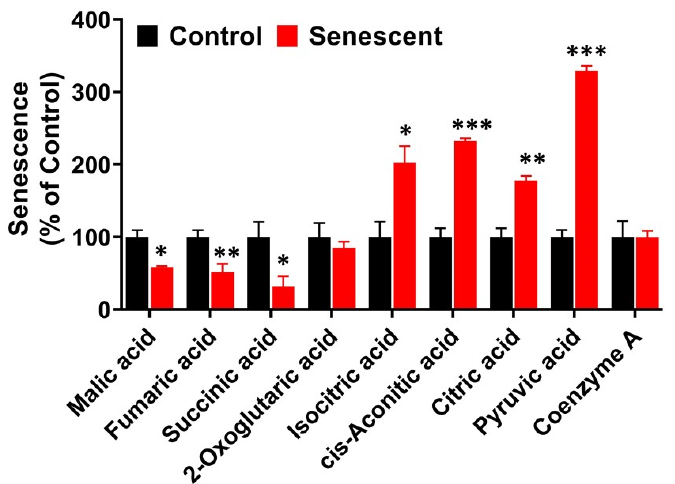
Figure 7. Levels of TCA (citric acid) cycle-related metabolites in control and senescent HCT-116 cells. Metabolites in senescent cells are expressed as percent of control based on protein concentration of samples. Results are ± SD of triplicate samples. Actual values obtained from analysis (nmoles/g protein) including p values and significance are presented in Table S2. * p value < 0.05; ** p value < 0.01, *** p value < 0.001.